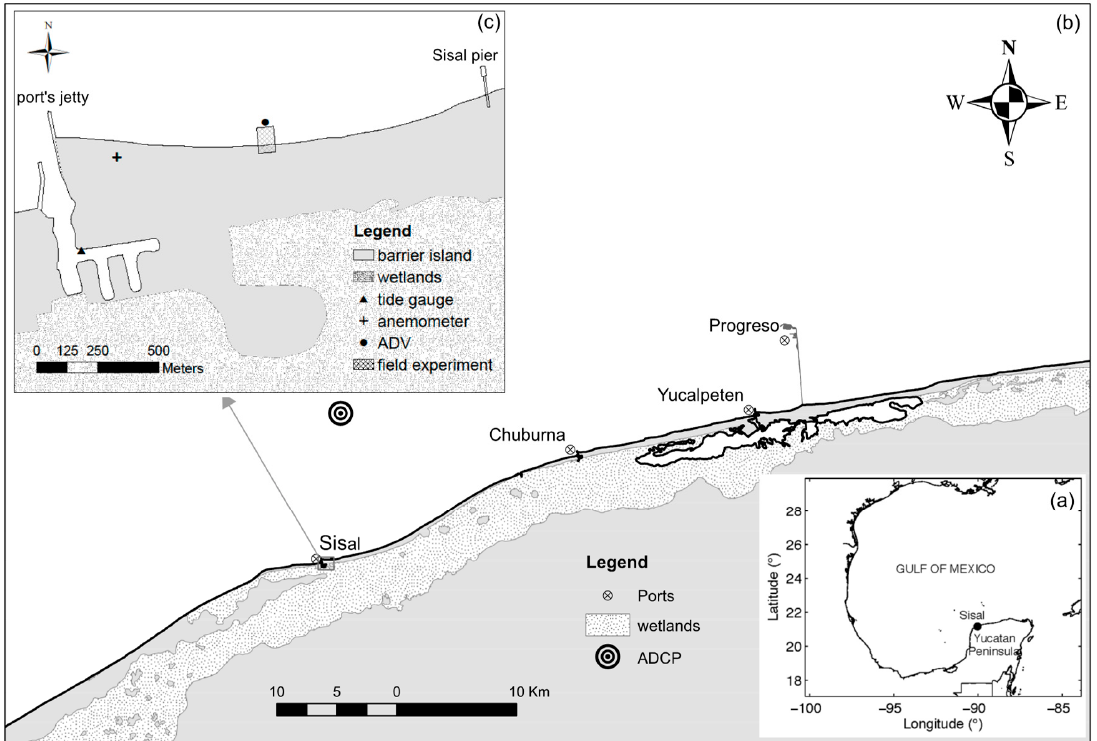
Figure 1. Location map showing ( a ) the Yucatan peninsula at the SE of the Gulf of Mexico, ( b ) a section of the Yucatan north coast showing the barrier island and wetlands and ( c ) the study area location, existing monitoring systems (ADCP: Acoustic Doppler Velocimeter Profile; ADV: Acoustic Doppler Velocimeter) and coastal structures.